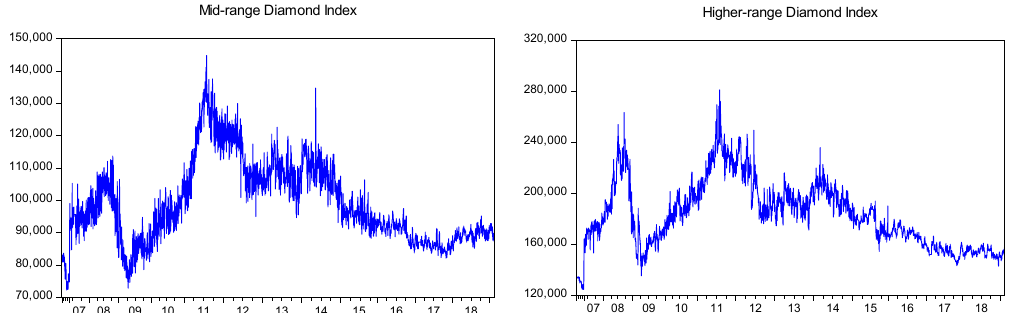
Figure 5. Mid-range and Higher-range diamond indices price dynamics. Notes: Price dynamics of diamond price indices: Mid-range Diamond Index (MDI) and Higher-range Diamond Index (HDI) in their original currencies (USD) for the period 4 June 2007–15 February 2019: Source : Polished Prices and D’Ecclesia and Jotanovic (2018).